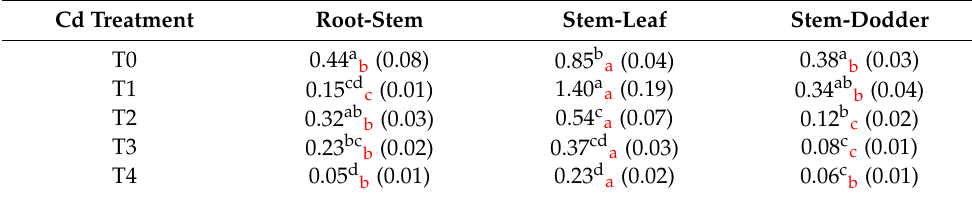
Table 1. Cadmium (Cd) transfer coefficients of various paths within the soybean-dodder parasitic system under different levels of Cd